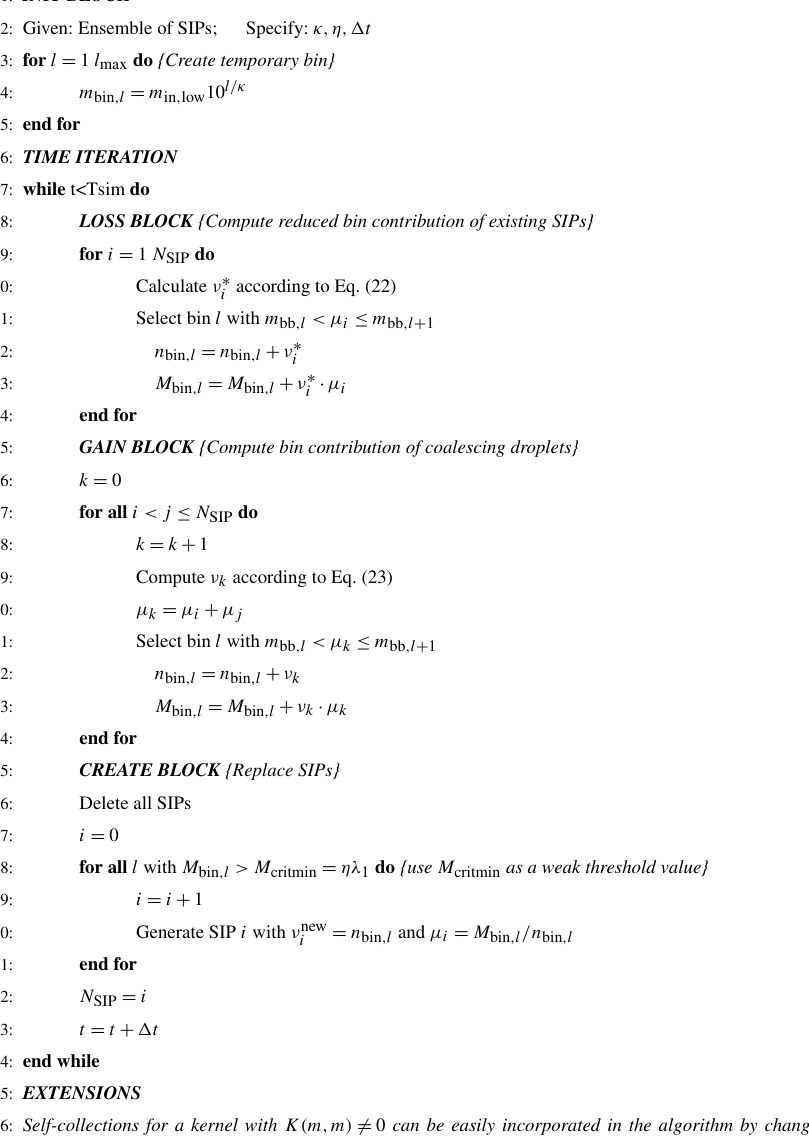
Algorithm 1 Pseudo-code of the Remapping algorithm (RMA); style conventions are explained at the end of Sect.